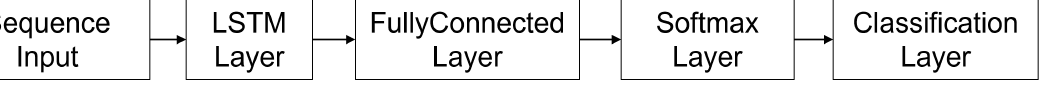
Figure 5. LSTM model for training, validation, and testing. Input is datasets one to eight, and the final classification layer gives the result of whether the input sample is infected or